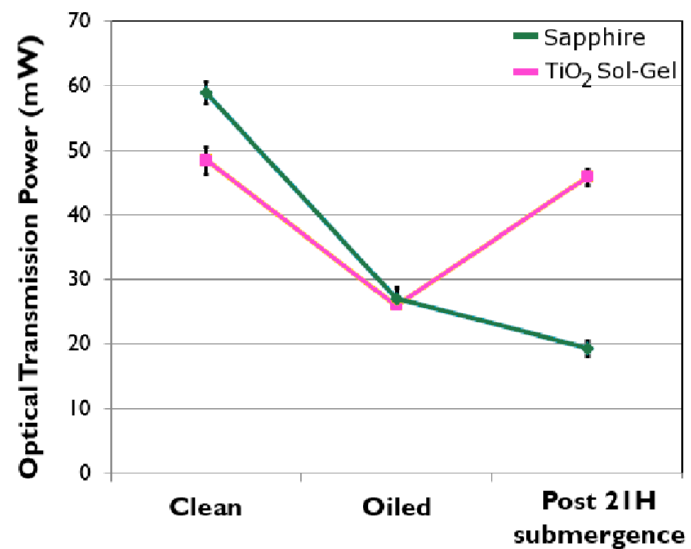
Figure 4. Optical 365 nm transmission power through samples before and after contamination and again after 21 h of submergence. Note: the sapphire control sample was not exposed during the submergence, as it represents the current non-photoactive window system.